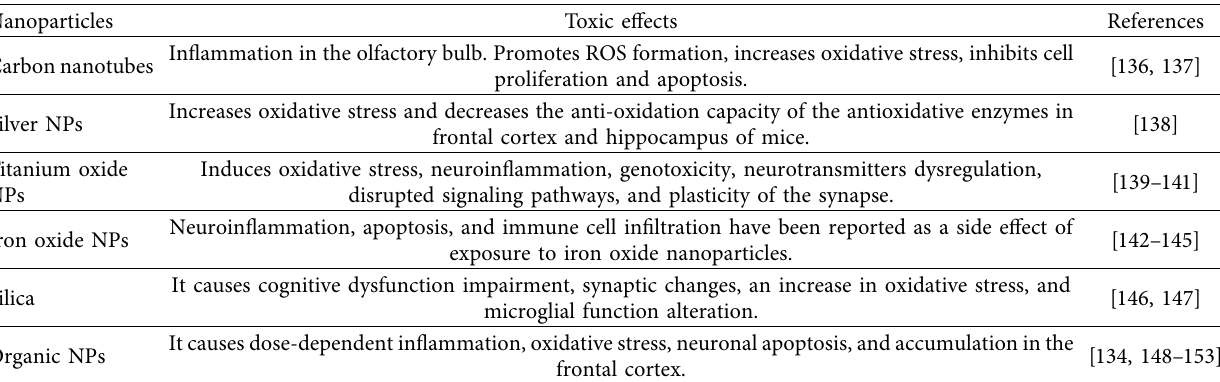
Table 3: Neurotoxic effects of some